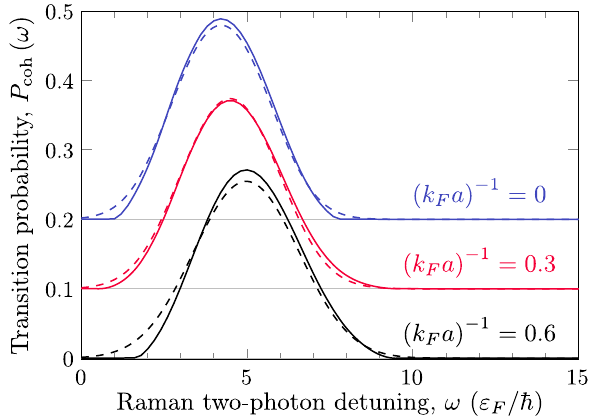
FIG. 10. Comparison of coherent part Raman spectra. Using the full many-body model for the Raman spectra [first term of Eq. (20), solid lines] and the approximation due to Eq. (13) (dashed lines), the coherent Raman rate is shown for three interaction strengths. In these calculations we use the effective mass and polaron energy obtained from the polaron Ansatz . For clarity, the second and third graphs from the bottom are shifted by 0.1 and 0.2,